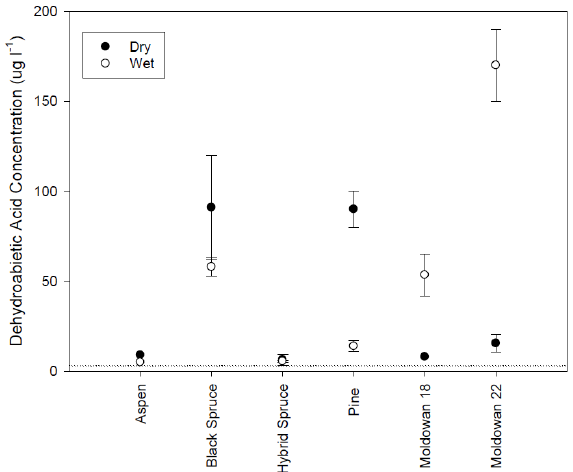
Figure 8. Mean dehydrobaietic acid concentrations and standard error ( n = 2) for different tree species and wood chip moisture conditions. Dashed line represents limit of detection